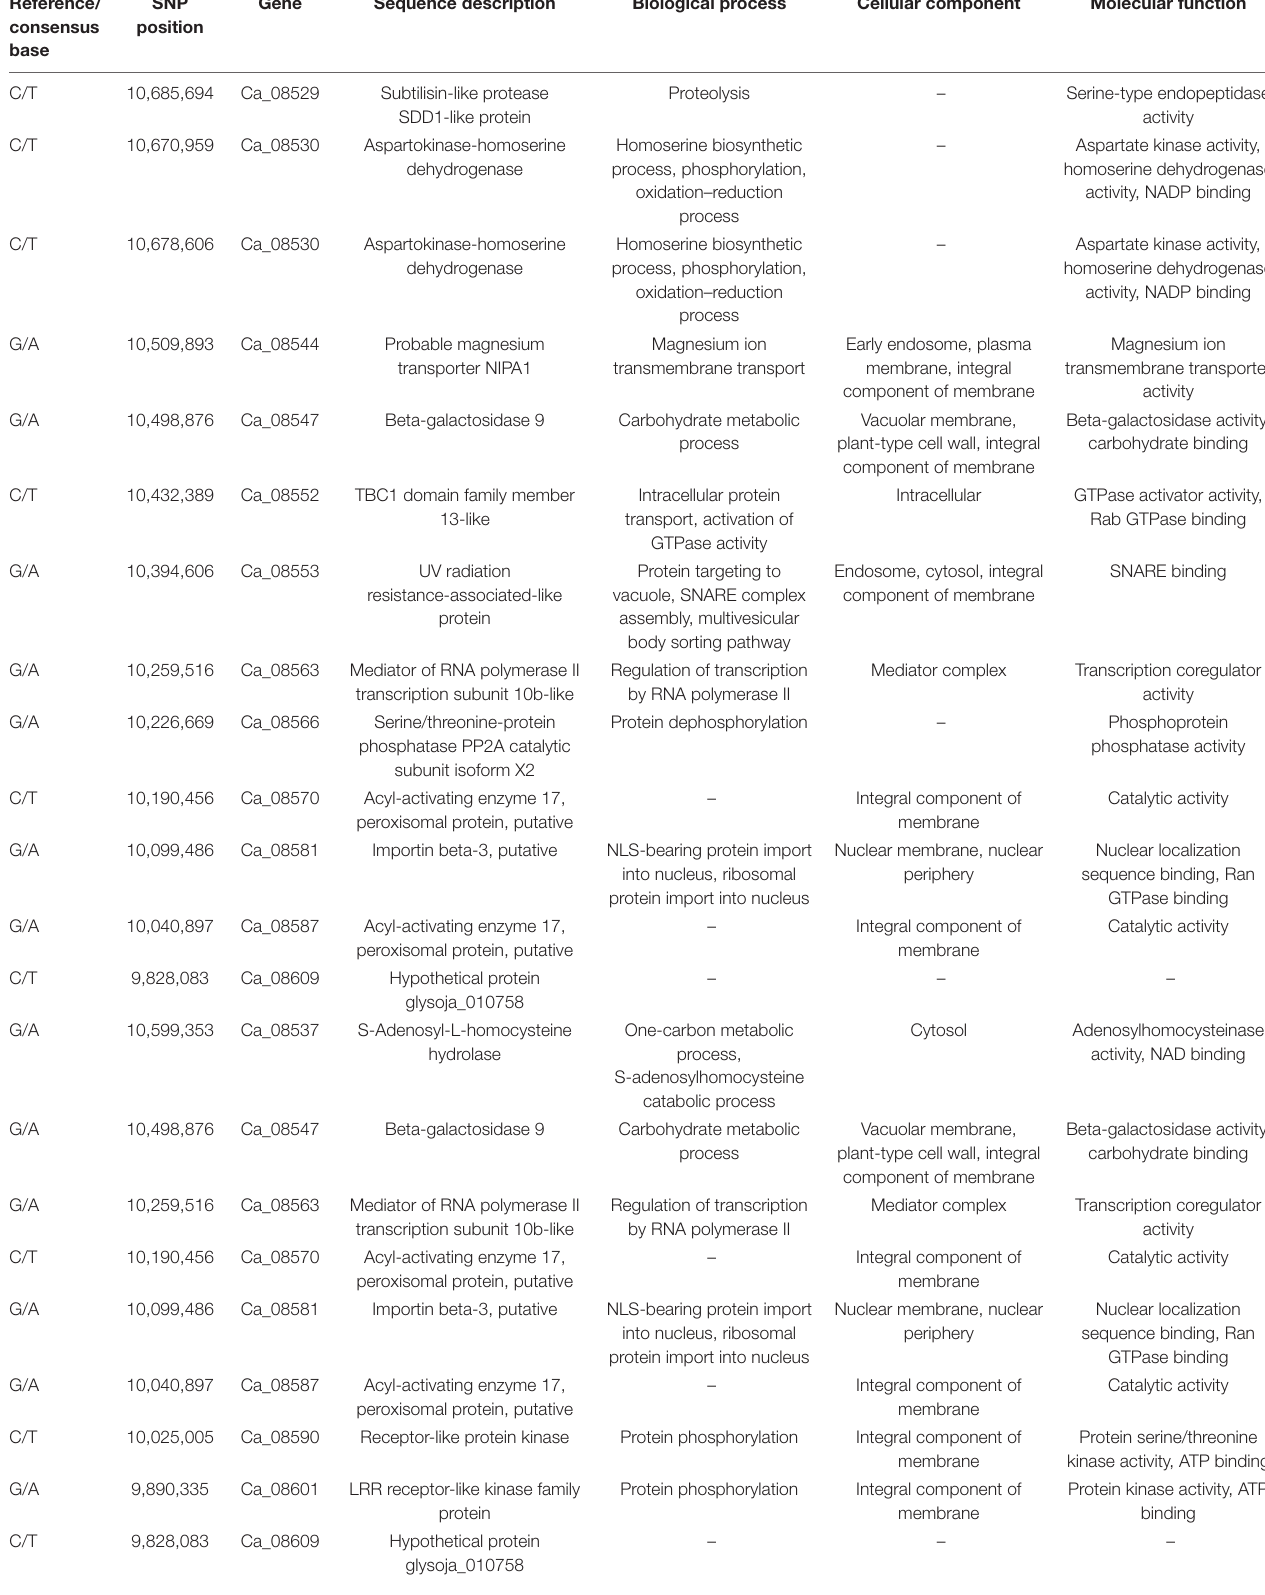
TABLE 4 | Summary of candidate genes in the genomic region on chromosome Ca6 harboring candidate SNPs with SNP-index = 1. Reference/